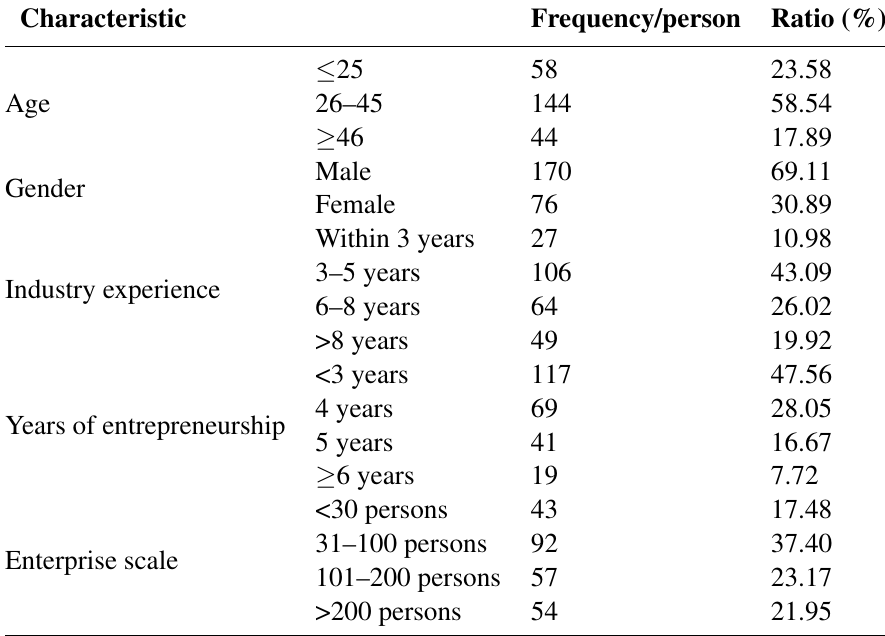
Table 1 Descriptive statistics of sample